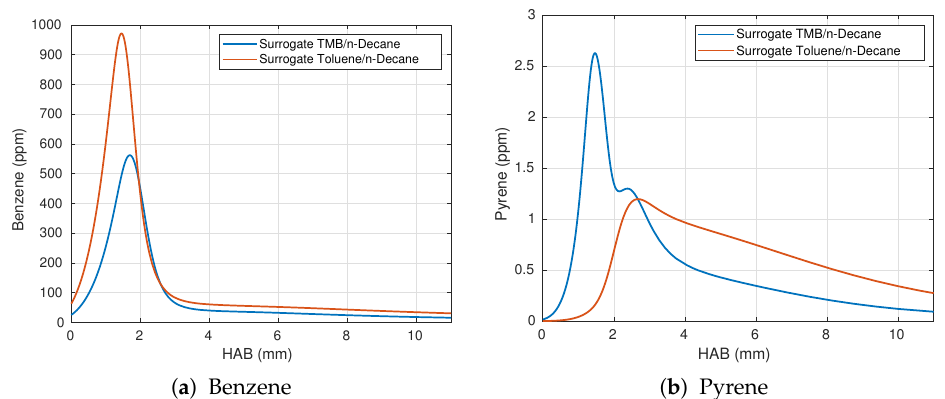
Figure 8. Comparison of numerically calculated species profiles for different mixture compositions— surrogate with trimethylbenzene (TMB) as well as surrogate with